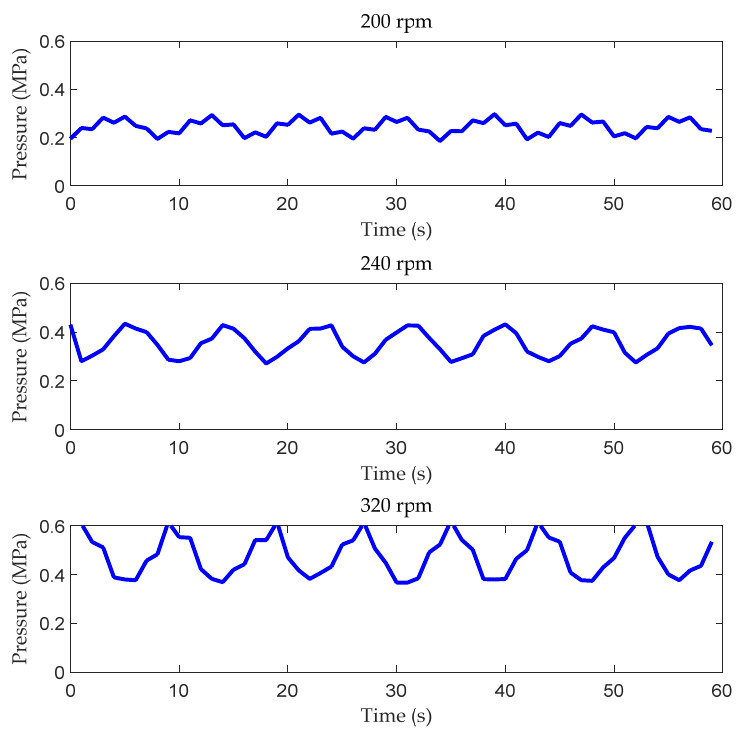
Figure 7. Pressure curves at different speeds.